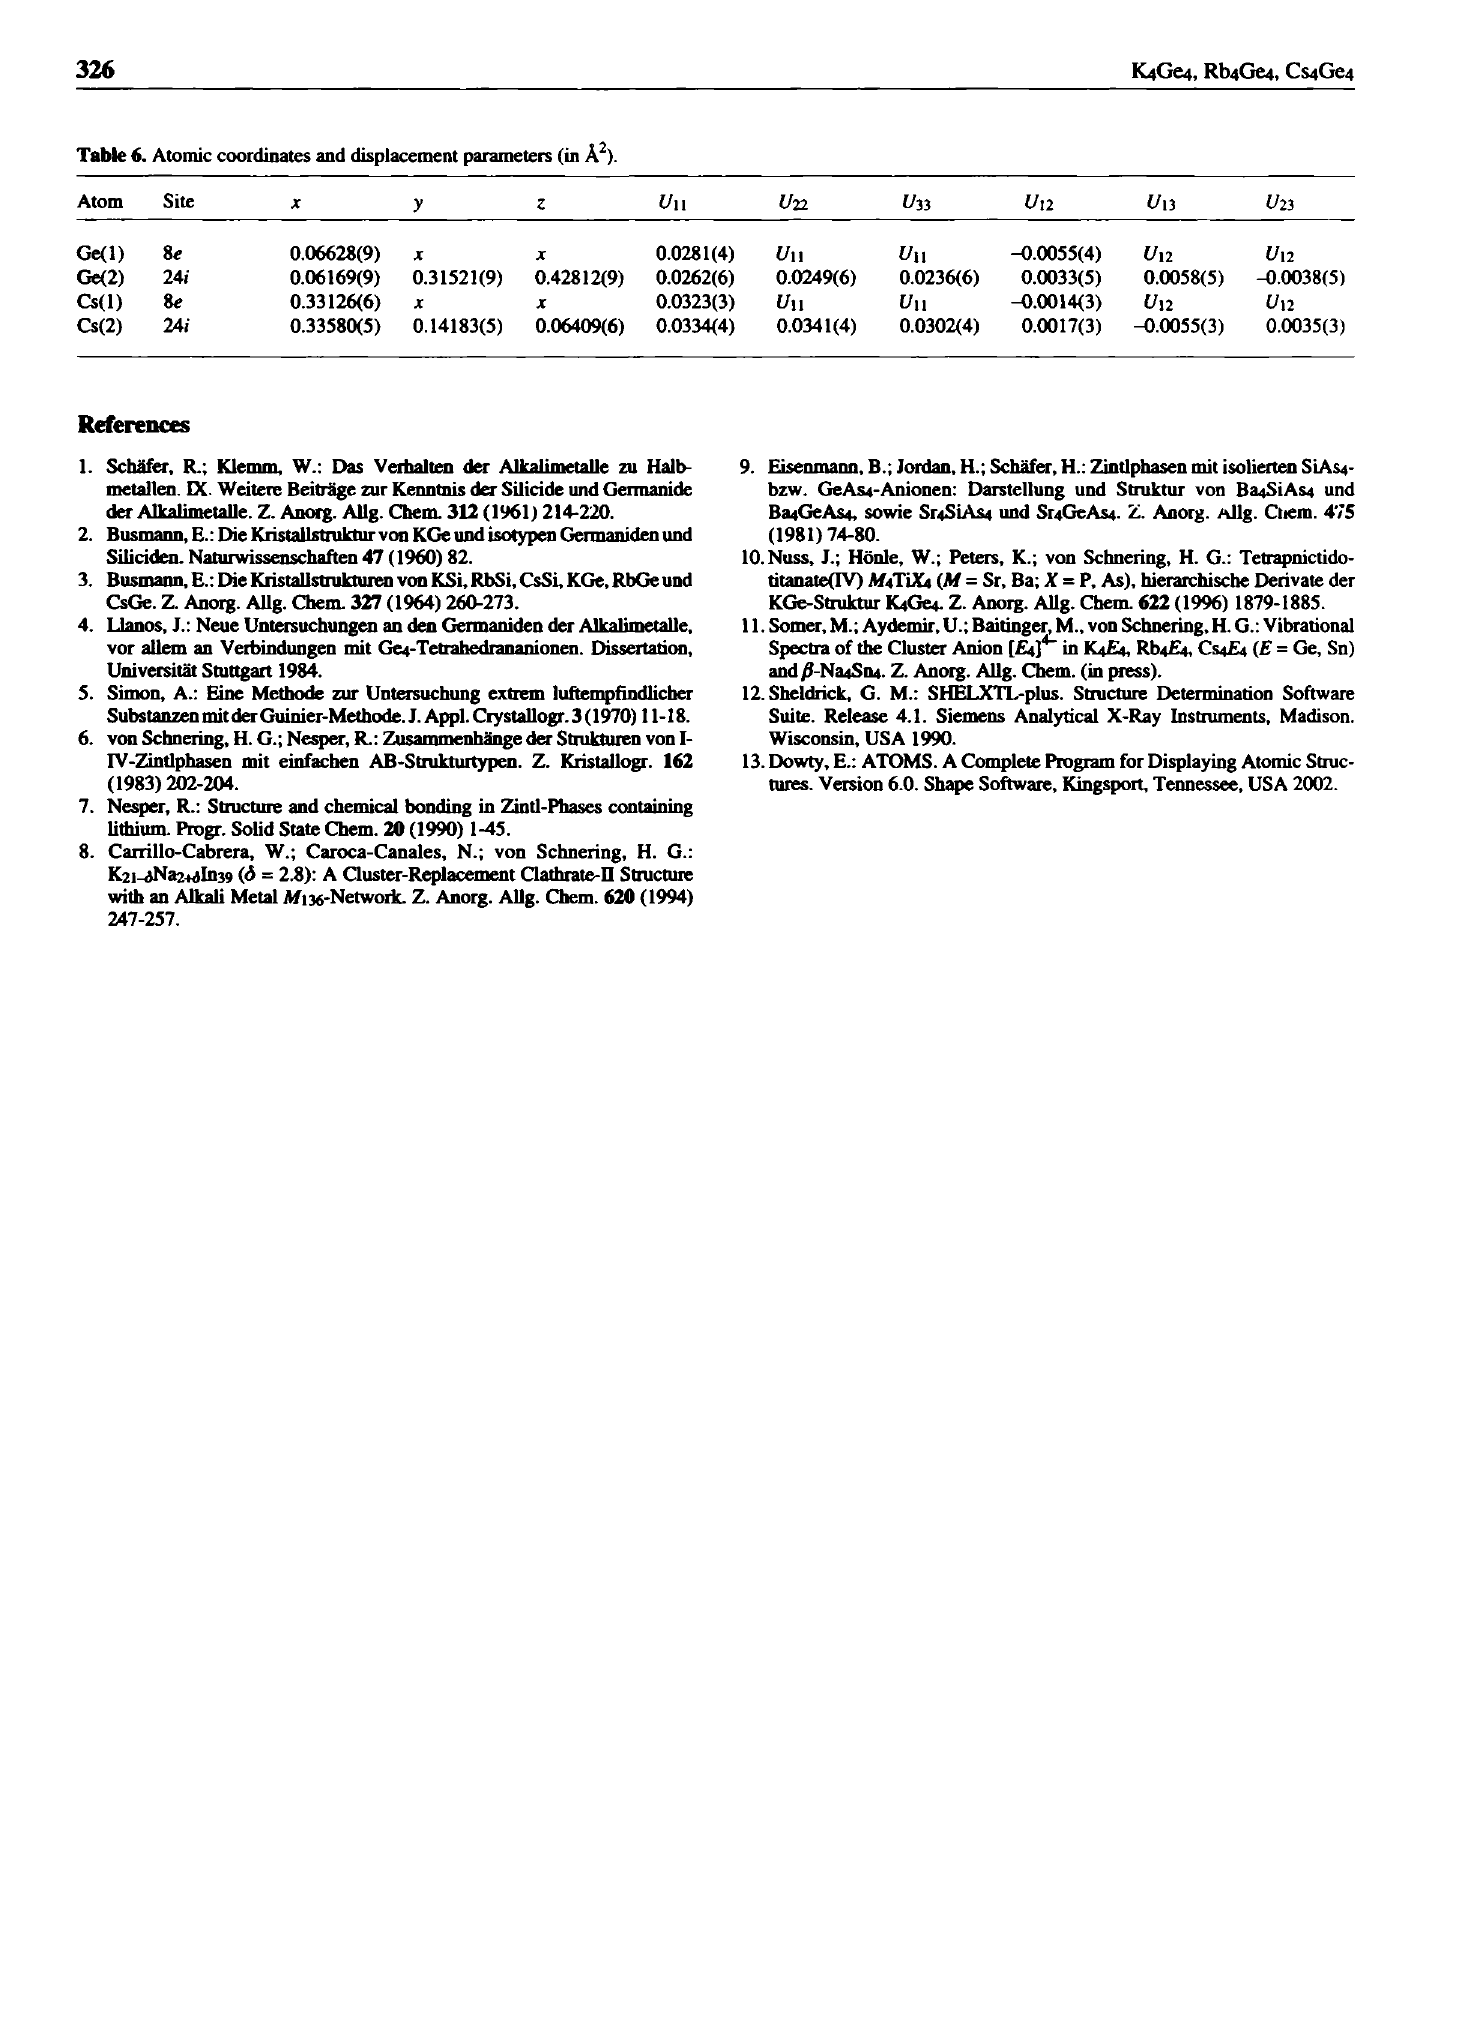
Table 6. Atomic coordinates and displacement parameters (in Ä 2